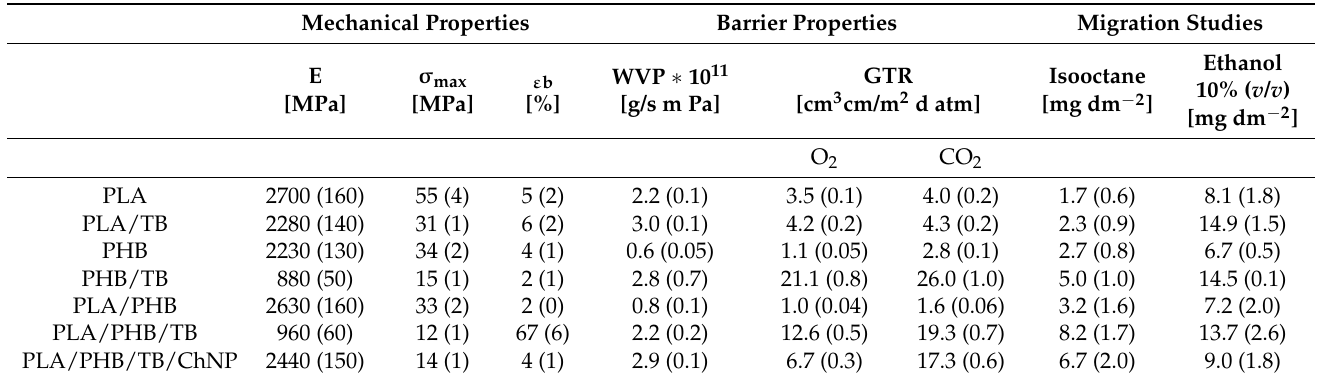
Table 5. Mechanical, barrier, and migration behavior of PLA- and PHB-based materials (values in brackets correspond to the standard